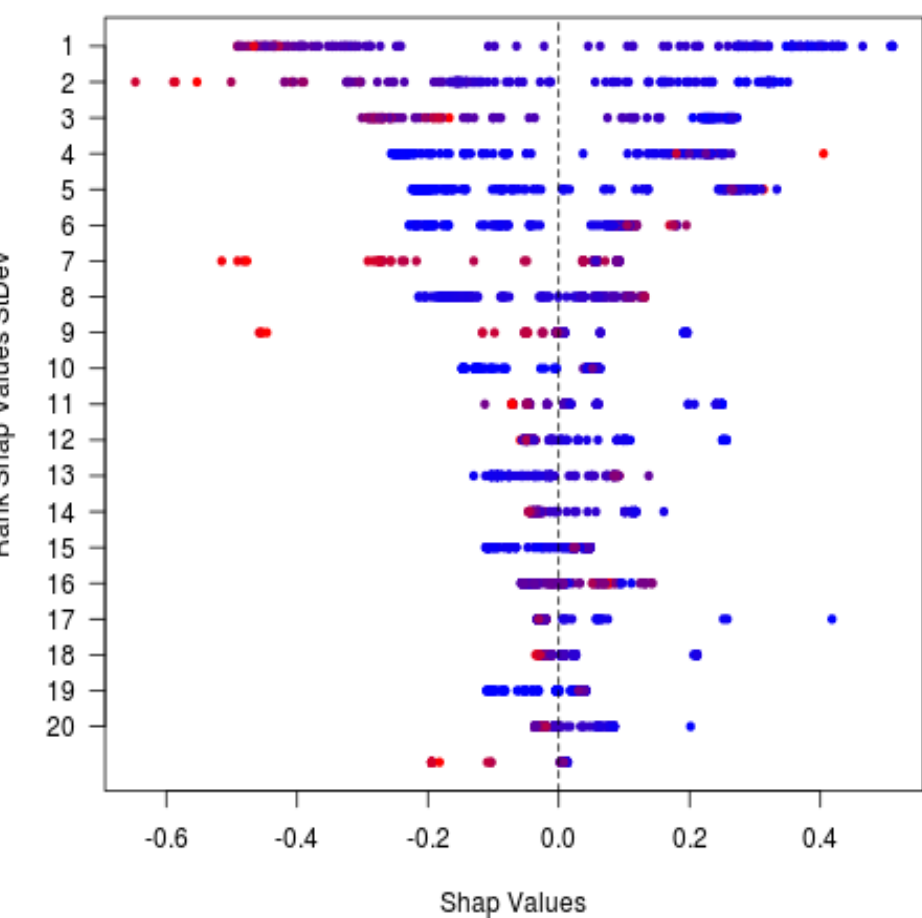
Figure 6. SHAP analysis external validation. SHAP analysis for the CNV type predictions in AVENUE. Every prediction contributes exactly one dot to each row. Blue and red colors indicate lower and higher feature values, respectively. SHAP values (x-axis) add up to the predicted probability for occult (only 20 features with highest SHAP variance shown here). BM, Bruch’s membrane; CNV, choroidal neovascularization; HFL, Henle’s fiber layer; IB, inner boundary; ILM, inner limiting membrane; IRF, intraretinal fluid; max, maximum; OB, outer boundary; OPL, outer plexiform layer; PED, pigment epithelial detachment; RPE, retinal pigment epithelium; SHAP, SHapley Additive exPlanations; and SHRM, subretinal hyperreflective material.